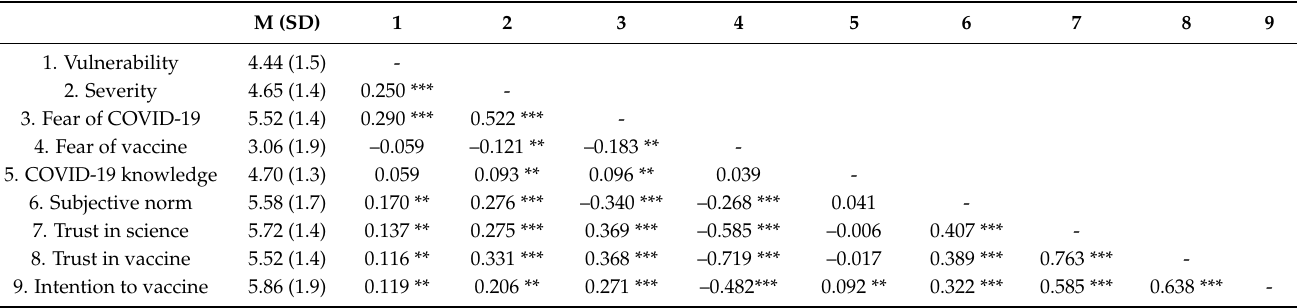
Table 1. Descriptive statistics and zero-order correlations among the variables of the